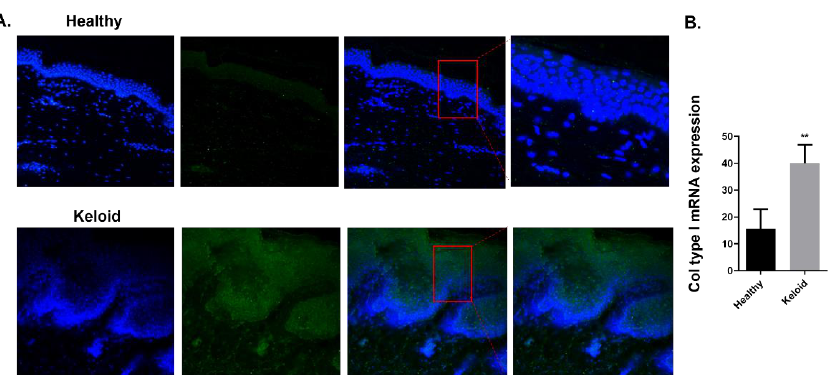
Figure 6. Increased molecular markers of fibrosis in skin biopsies of human keloids. Human skin tissue was obtained from healthy controls and patients with keloids. ( A ) Representative immunoflu- orescence microscope images of skin sections from healthy and keloid samples for alpha smooth muscle actin ( α -SMA) immunostaining. DAPI, blue nuclei. Original magnification: × 20; Scale 100 µ m. Levels of ( B ) Collagen type I (Col type I) messenger RNA were assessed by real-time PCR. ( B ) The graphs present data from n = 8 (Healthy) and n = 8 (Keloid) samples. Results are presented as mean ± SEM. Statistical analysis was performed by Mann–Whitney test (one-tailed). ** p < 0.01 vs. healthy